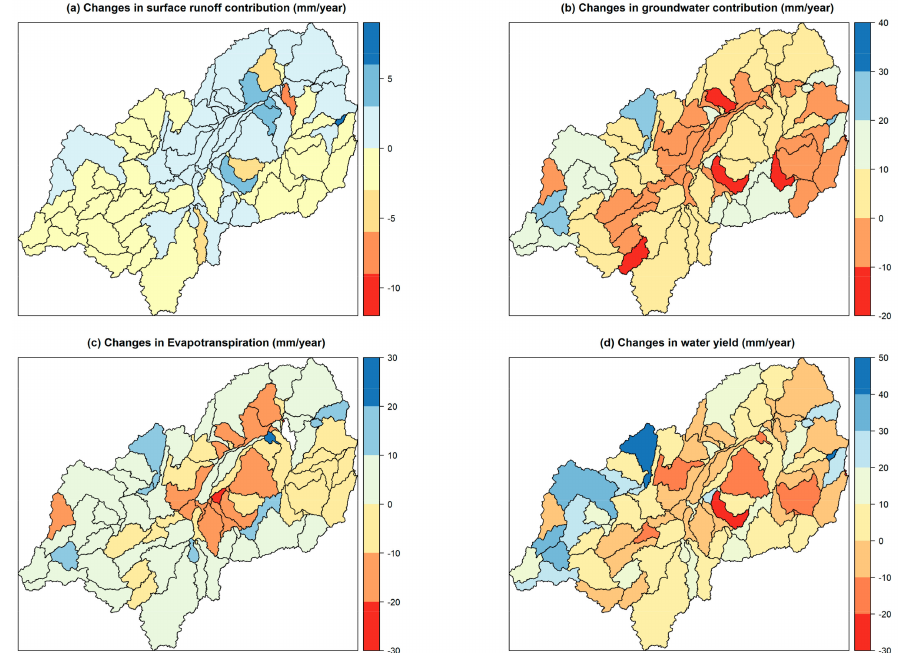
Figure 14. Average shifts in water balance components (in mm) for the simulation period, while comparing changes from the 2004 land use map with the 2014 land use map. ( a ) Changes in surface runoff, ( b ) groundwater contribution, ( c ) evapotranspiration, and ( d ) the overall water